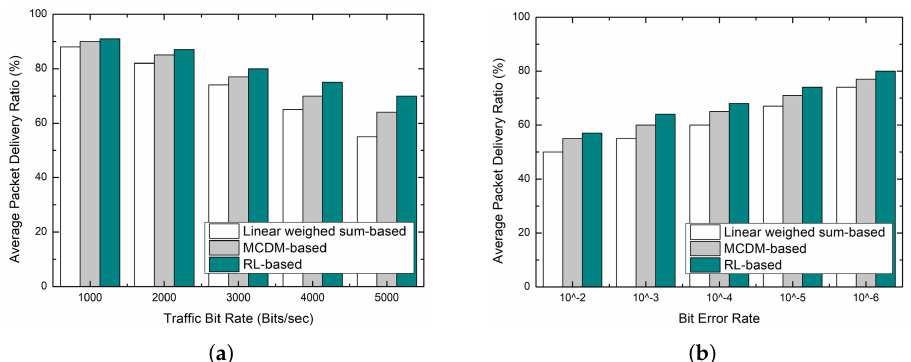
Figure 5. Simulation results: packet delivery ratio. ( a ) Packet delivery ratio according to traffic bit rate; ( b ) Packet delivery ratio according to bit error rate.